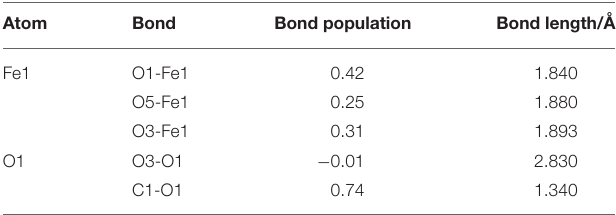
FIGURE 2 | The optimal bond of oleate on an ilmenite (1 0 4) surface, the red ball is O, the blue ball is Fe, the light gray ball is Ti, the dark gray ball is C, and the white ball is H. energy of (1 0 4) was lower than that of (1 1 0), which implied that TABLE 3 | Mulliken population of adsorption configuration of oleate on